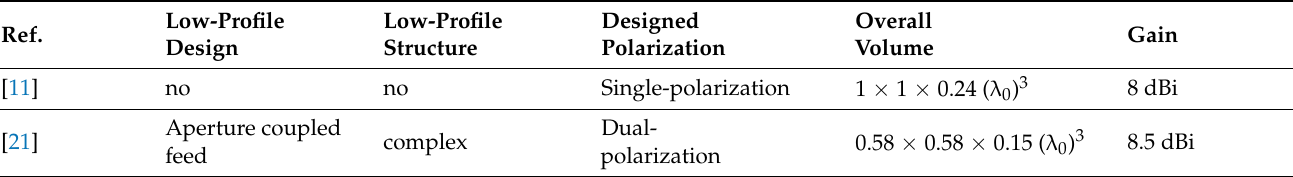
Table 3. Comparison with other low-profile MEDs. ( λ 0 is the wavelength at the center frequency).